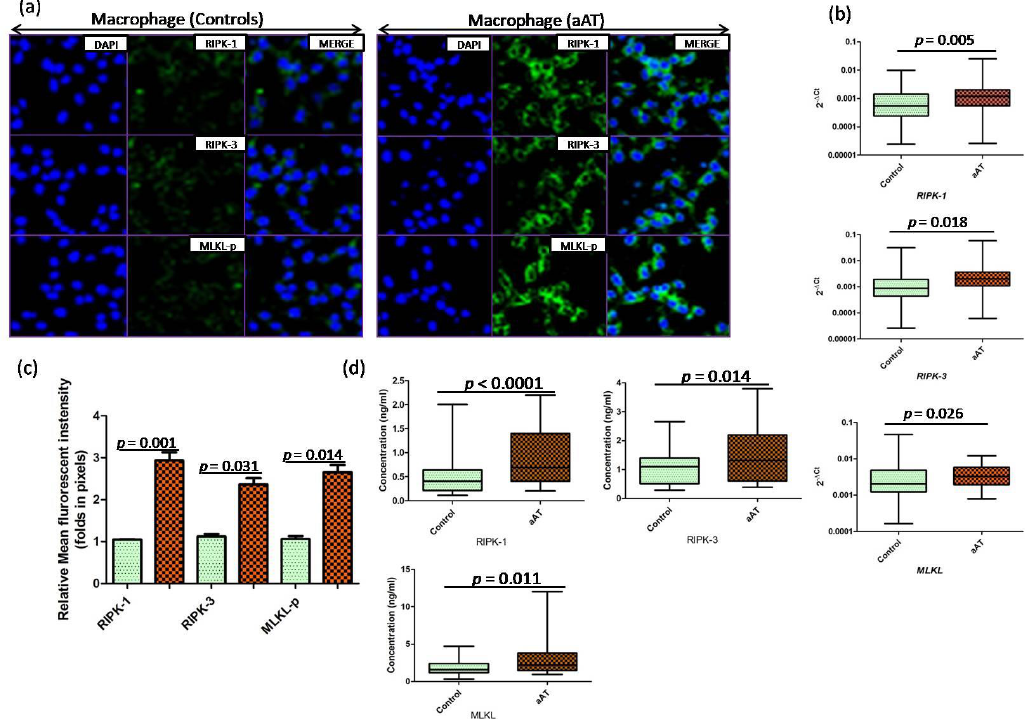
Figure 3. ( a ) Effect of IL – 33 – primed neutrophils/NETs on the necroptosis of the cultured macro- phages in aAT patients and controls; ( b ) qPCR-based transcript expression of necroptosis markers ( RIPK – 1, RIPK – 3, and MLKL ); ( c ) quantification (relative mean fluorescent intensity) of necroptosis markers in the treated macrophages of the aAT patients and controls; ( d ) RIPK – 1, RIPK – 3, and MLKL protein quantification by ELISA in cell lysates.